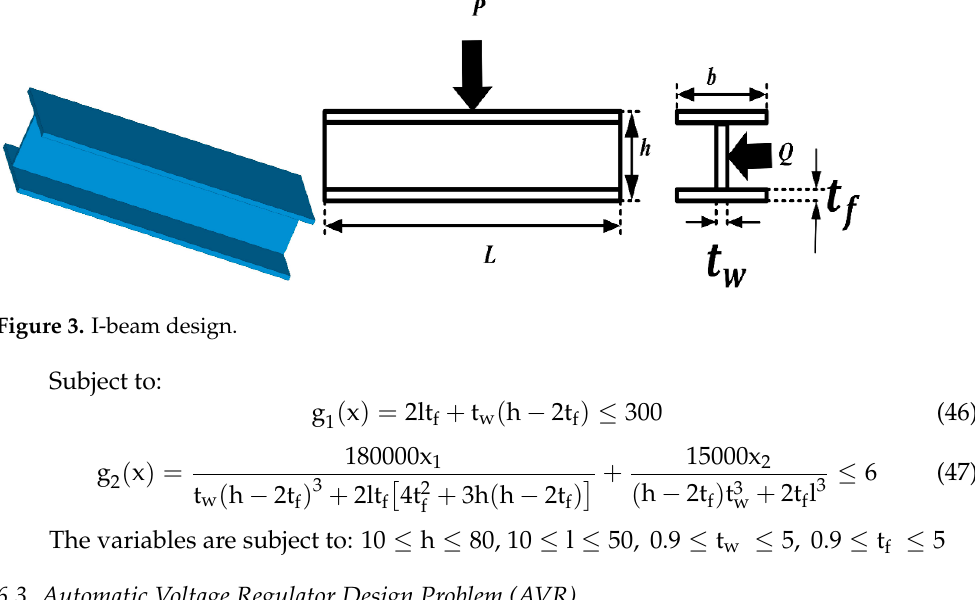
Figure 3. I-beam design.